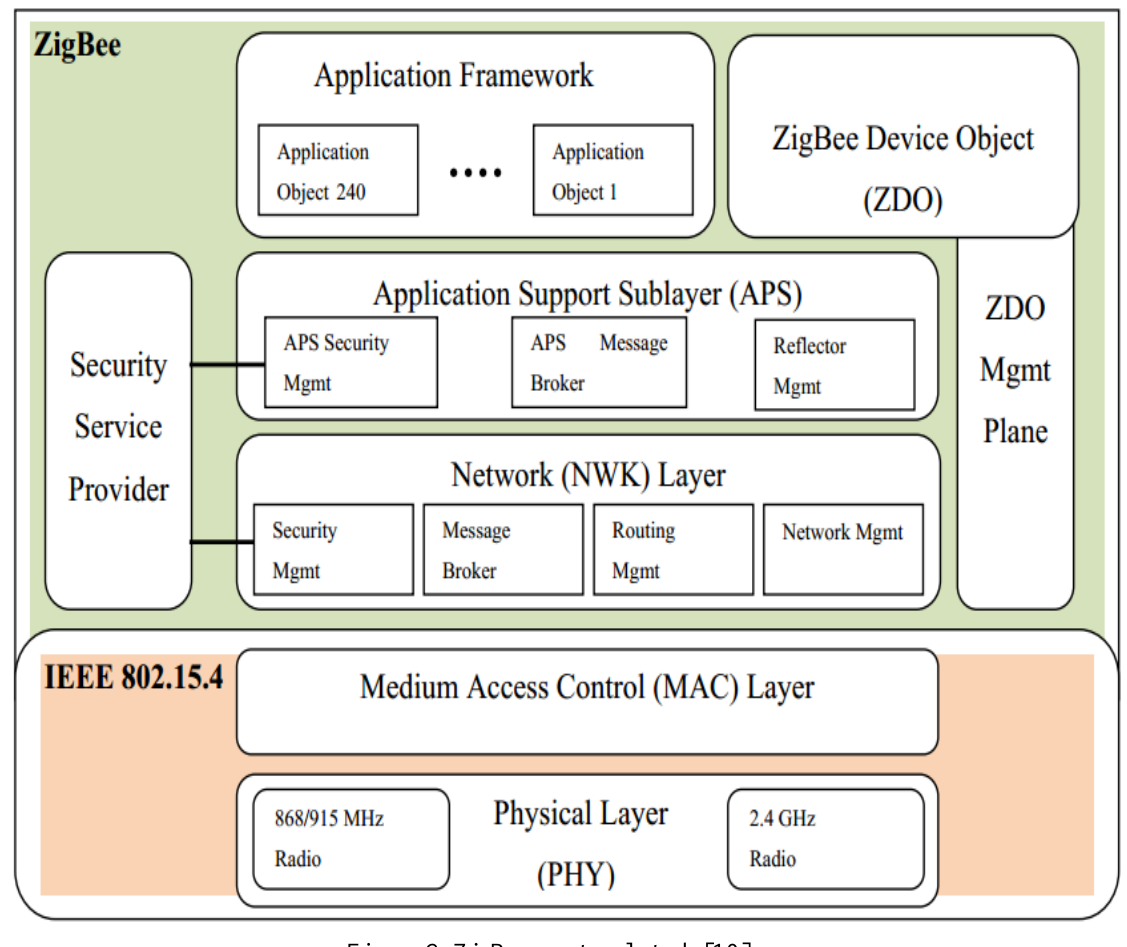
Figure 2. ZigBee protocol stack